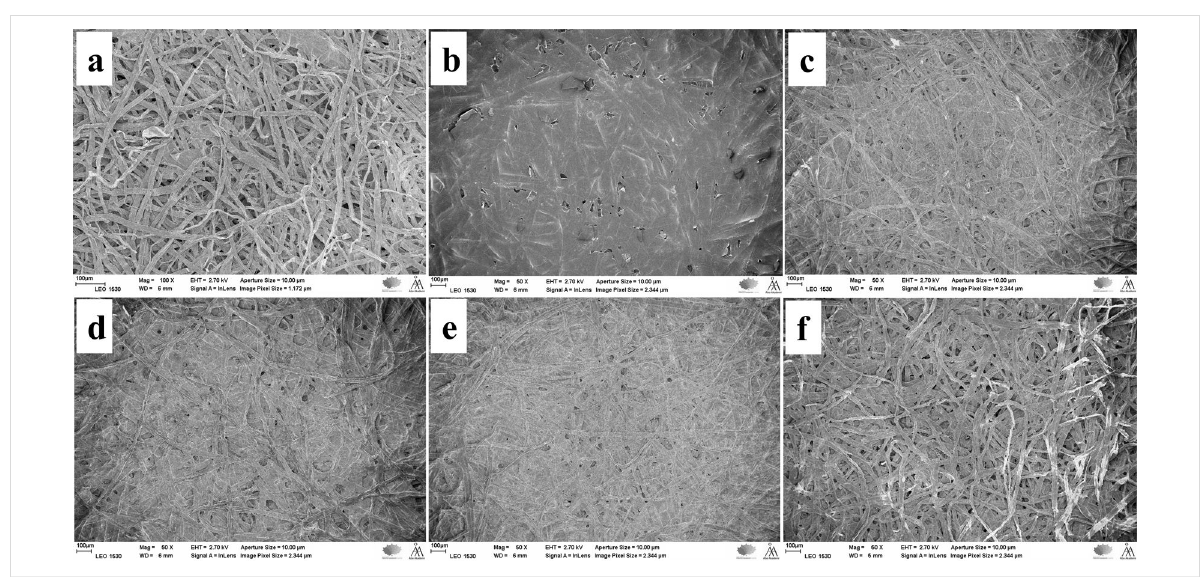
Figure 6: SEM images of the BKPR fibers: (a) REF (b) C-F (c) HF (d) C-HF (0.15 M) (e) C-HF (0.30 M) (f) C-HF (0.45 M).